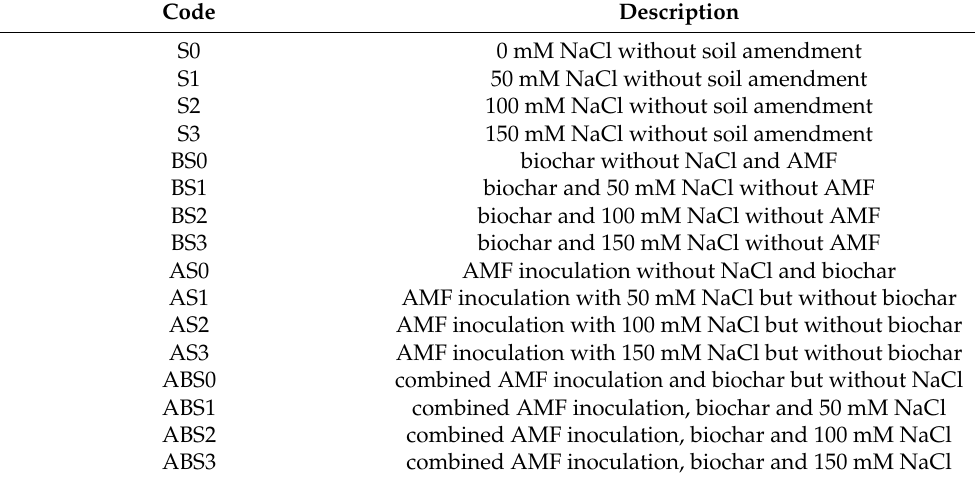
Table 2. Treatment